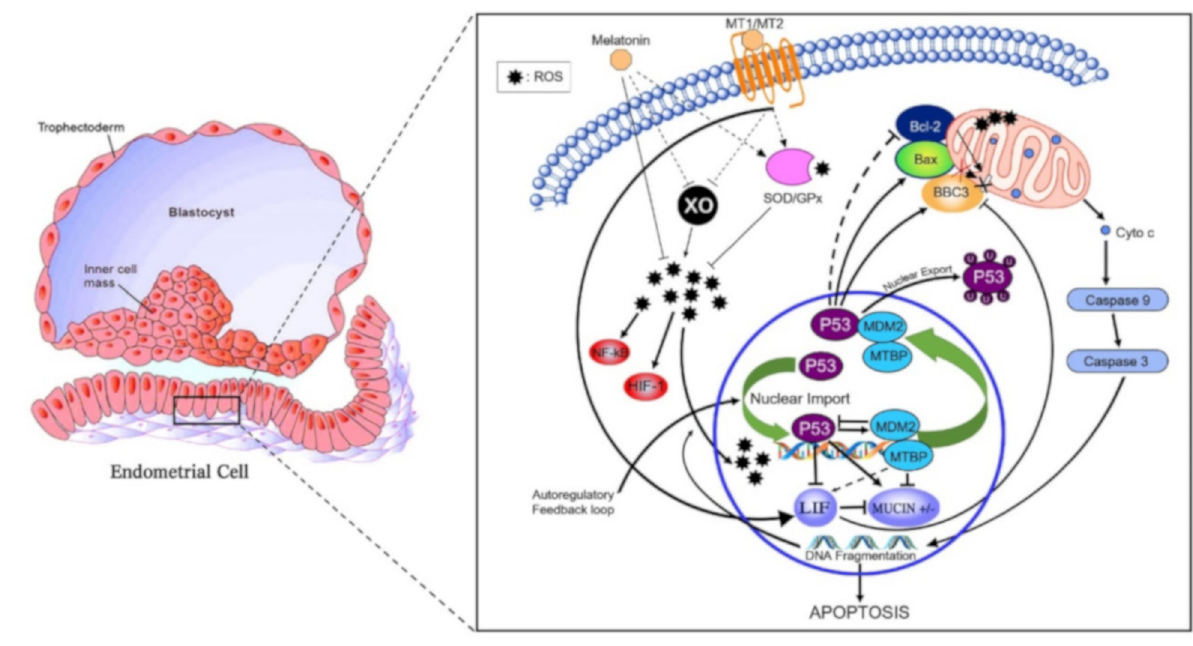
Figure 5. Proposed antiapoptotic pathway of melatonin in the bovine endometrial cell. Abrupt envi- ronmental change at pregnancy from hypoxic to hyperoxic induces xanthine oxidase (XO) expression and activity, thereby generating reactive oxygen species (ROS). ROS-induced DNA fragmentation caspase 3. Downstream effects of caspase 3 include increasing DNA fragmentation. Melatonin, via its as glutathione peroxidase (GPx) antioxidant enzymes. XO expression and activity is indirectly